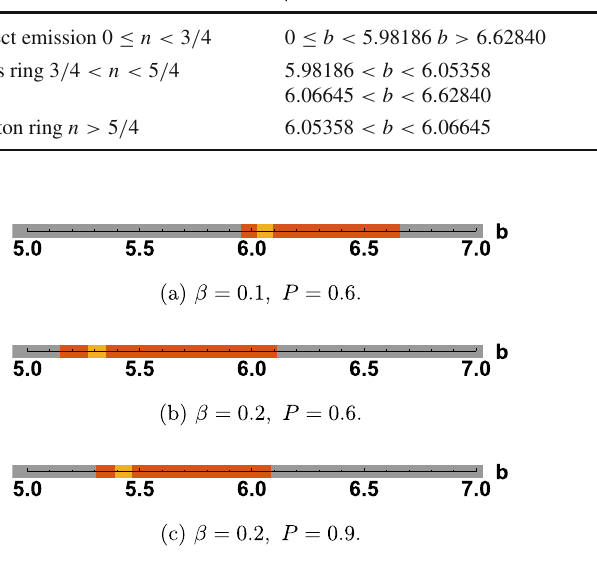
Fig. 10 Visualization of Table 4. The grey, red, and yellow ranges are direct emission, lens ring, and photon ring, respectively